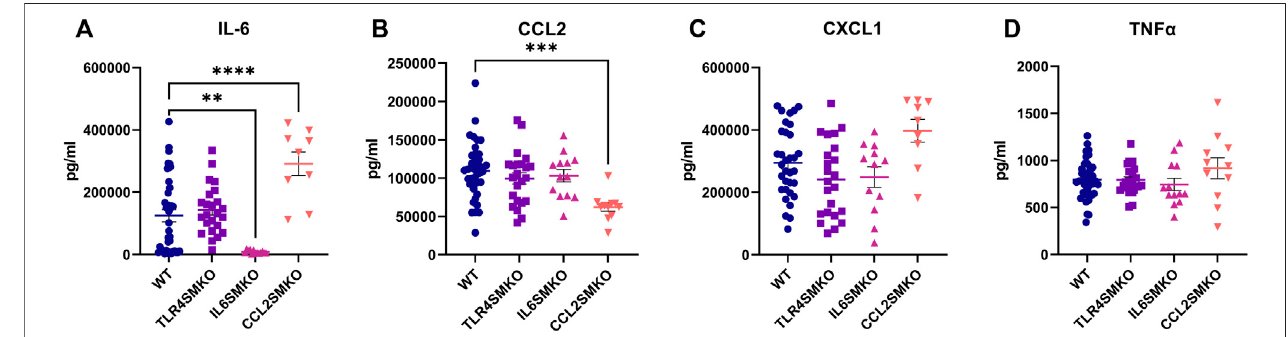
FIGURE 3 | Skeletal muscle cytokine secretion in fl uences systemic cytokine concentrations. Serum collected from mice containing myocyte speci fi c conditional knockoutsofTLR4(TLR4SMKO, n =23),IL-6(IL6SMKO, n =13),CCL2(CCL2SMKO, n =11),orlittermatecontrols(WT, n =39)wasmeasuredforconcentrationsofIL- 6 (A) ,CCL2 (B) ,CXCL1 (C) ,andTNF α (D) 3 hafterIVLPS.Datawerecomparedusingone-wayANOVAwithDunnett ’ smultiplecomparisontest. p < 0.05*, p < 0.01**, p < 0.001